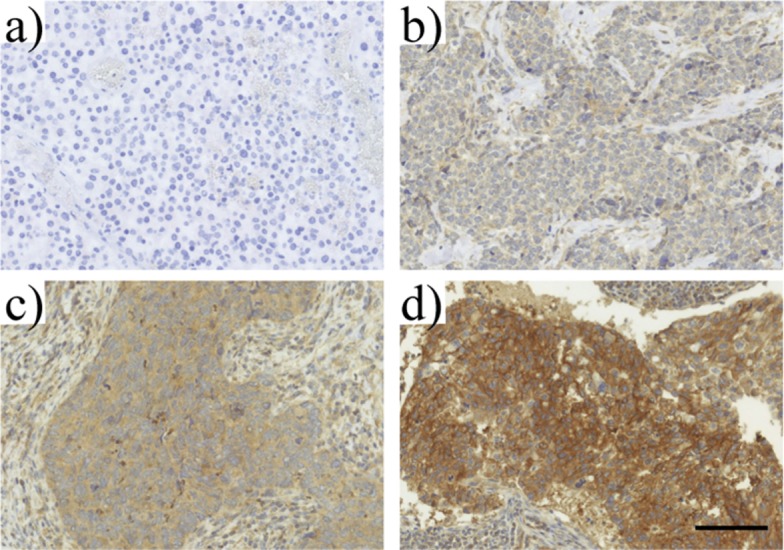
Examples of immunohistochemical TLR9 stainings in tissue sections of paraffin-embedded TNBC blocks from African American women.The staining examples represent a) negative, b) low, c) intermediate and d) high TLR9 expressing TNBC tumors. Staining results in a & b represent the low TLR9-group (TLR9 score ≤ 8), whereas c & d represent the high tumor TLR9-group (TLR9 score > 8).